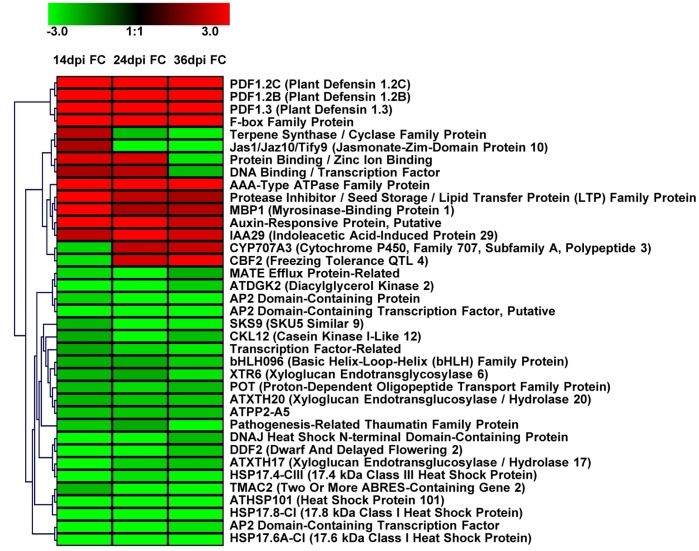
Gene tree heat map showing hierarchical clustering of 37 out of 41 transcripts expressed continuously across time points 14, 24, and 36 dpi (4 unknowns were not displayed).Red bars indicated induction (>2.0) and green bars, repression (<−2.0). Abbreviations: FC (Fold Change).